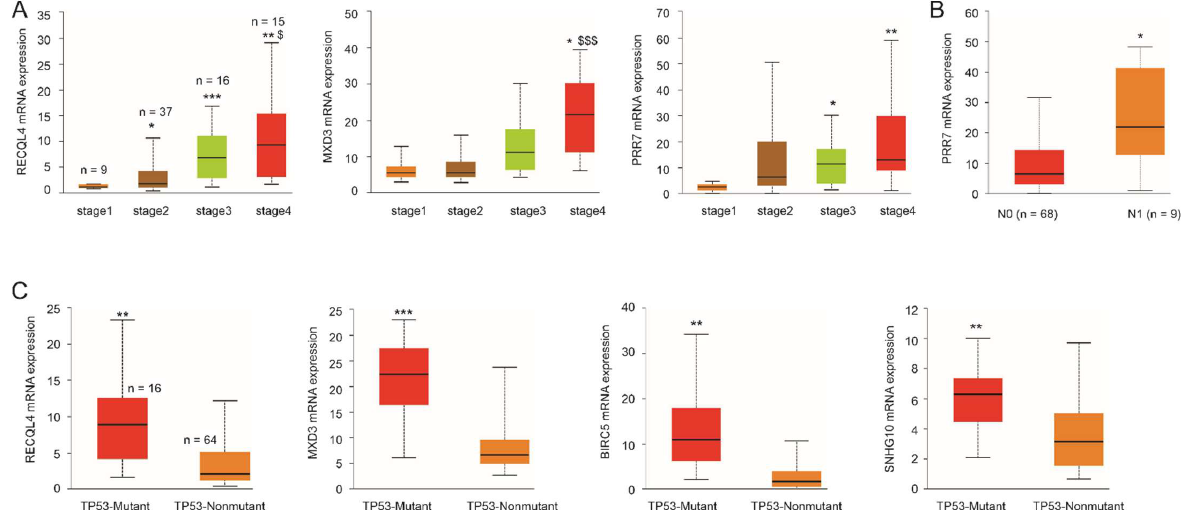
Figure 7. Associations of component gene expressions with tumor stage ( A ), lymph node metastasis ( B ), and TP53 mutations ( C ). Analyses were performed using the TCGA data organized by the UALCAN platform [29]. * p < 0.05; ** p < 0.01; *** p < 0.001 in comparison to stage 1 ( A ), N0 ( B ), and TP53- Nonmutant tumors. $ p < 0.05; $$$ p < 0.001 in comparison to stage 3 ACCs ( A ).